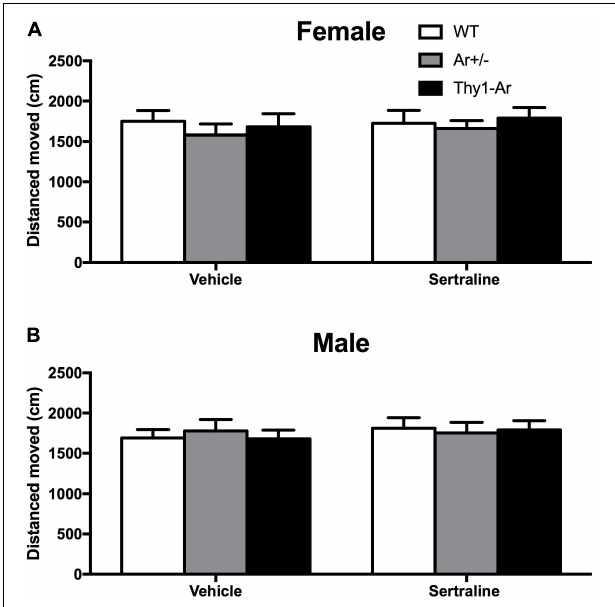
FIGURE 2 | Sertraline did not alter spontaneous locomotor activity in all three genotypes regardless of sex difference. No differences were found in total distance moved in spontaneous locomotor activity in both (A) female and (B) male mice treated by vehicle or sertraline. Data represent means ± SEM ( N = 6–7 mice/group), as evidenced by the two-way